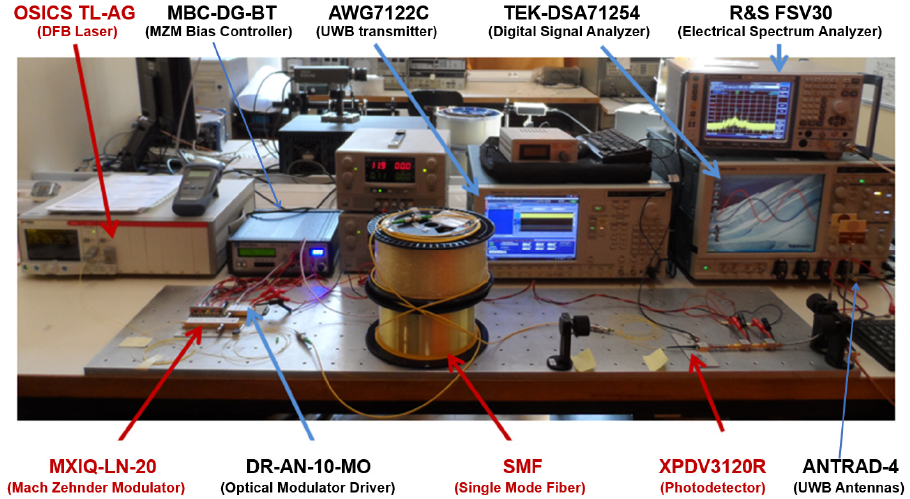
Figure 6. Experimental implementation of the optical-wireless SLF IR-UWBoF-EIM/DD system.